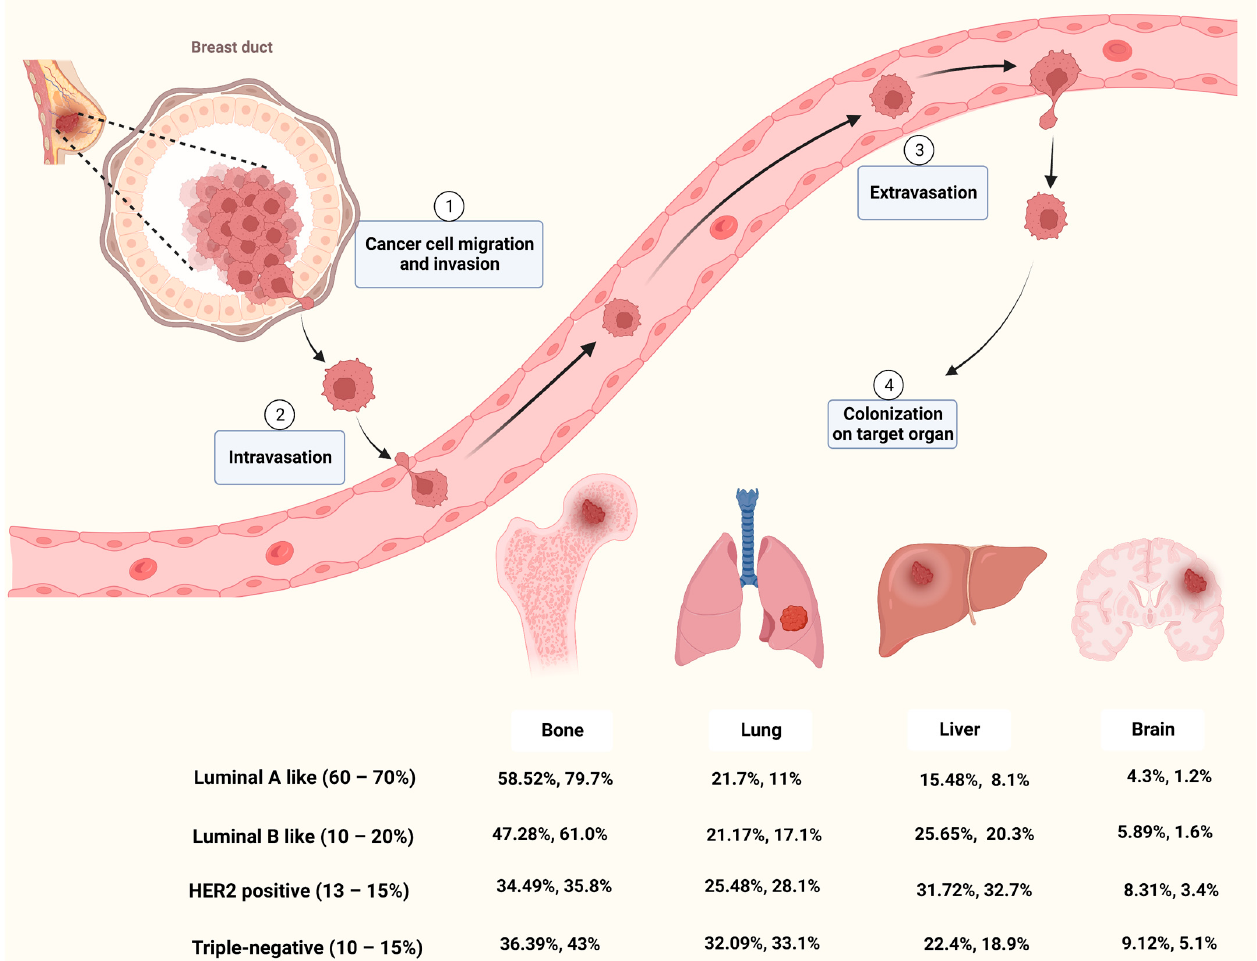
Figure 1. Breast cancer metastasis to bone, lung, liver and brain [5,15,16]. Figure is created by Bi- oRender.